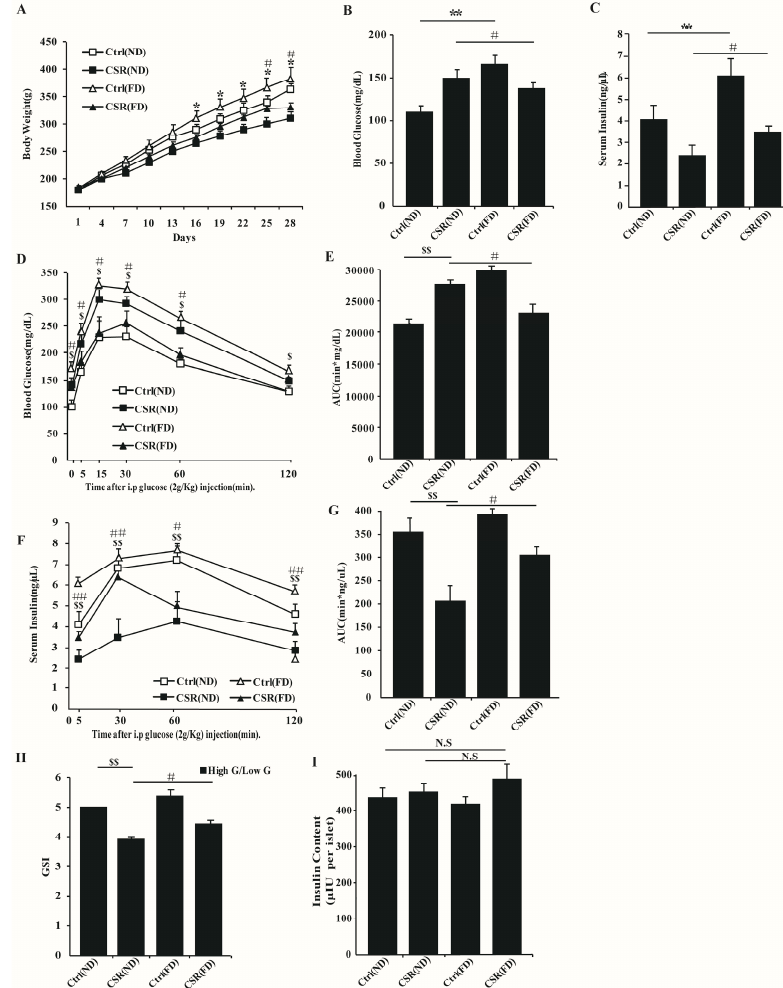
Figure 7. Increased dietary fat restored islet dysfunction induced by chronic sleep restriction partially: ( A ) Body weight was monitored during CSR in ND and FD groups ( n = 10). Fasting blood glucose ( B ); and serum insulin ( C ) were measured after CSR in ND and FD groups ( n = 10); ( D ) IPGTTs were performed at the end of CSR treatment ( n = 5); ( E ) The AUC of ( D ); ( F ) Analysis of serum insulin levels during IPGTTs ( n = 5); ( G ) The AUC of ( F ); ( H ) Isolated islets were analyzed for insulin secretion by incubation in response to stimulation with 3.3 mM glucose (Low G ) and 16.7 mM glucose (High G ) ( n = 5); ( I ) Analysis of insulin content in isolated islets used in ( H ) ( n = 5). ND = Normal Diet; FD = diet supplemented with fatty acids. White squares = Ctrl(ND) group; black squares = CSR(ND) group; white triangle = Ctrl(FD) group; black triangle = CSR(FD) group. * p < 0.05, ** p < 0.01, Ctrl(FD) vs. Ctrl(ND) rats ; $ p < 0.05, $$ p < 0.01, Ctrl(ND) vs. CSR(ND) rats; # p < 0.05, ## p < 0.01, CSR(FD) vs. CSR(ND) rats. N.S = no significant change.